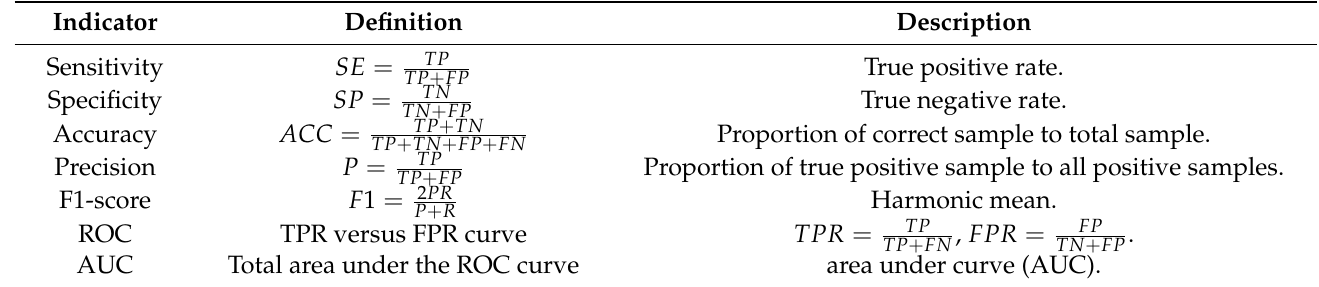
Table 2. Evaluation